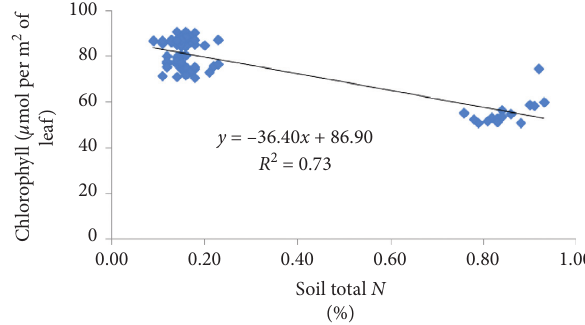
Figure 2: Relationship between pepper leaf chlorophyll concen- tration and soil total N in a pepper farm grown with mature vines.